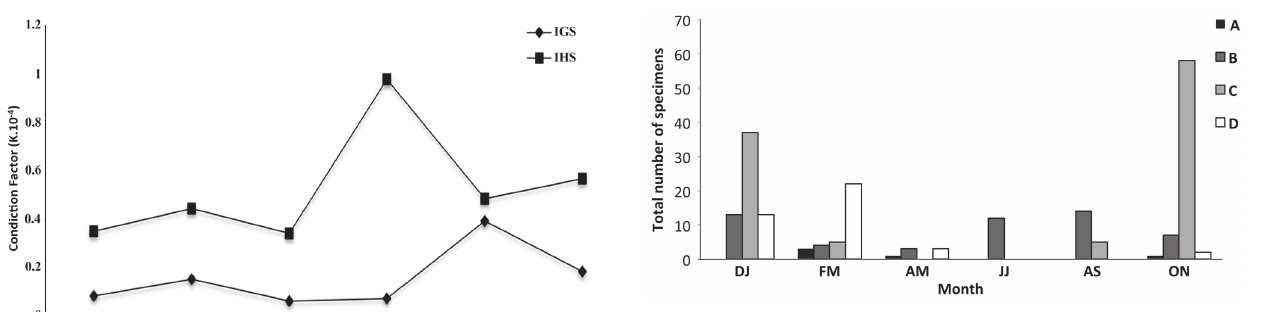
Fig. 12. Bimonthly distribution of gonad maturity stages of Loricariichthys melanocheilus females in the rio Ibicuí, Rio Grande do Sul. DJ = December/January, FM = February/ March, AM = April/May; JJ = June/July, AS = August/ September, ON = October/November); A = immature, B = developing, C = mature D = spent.